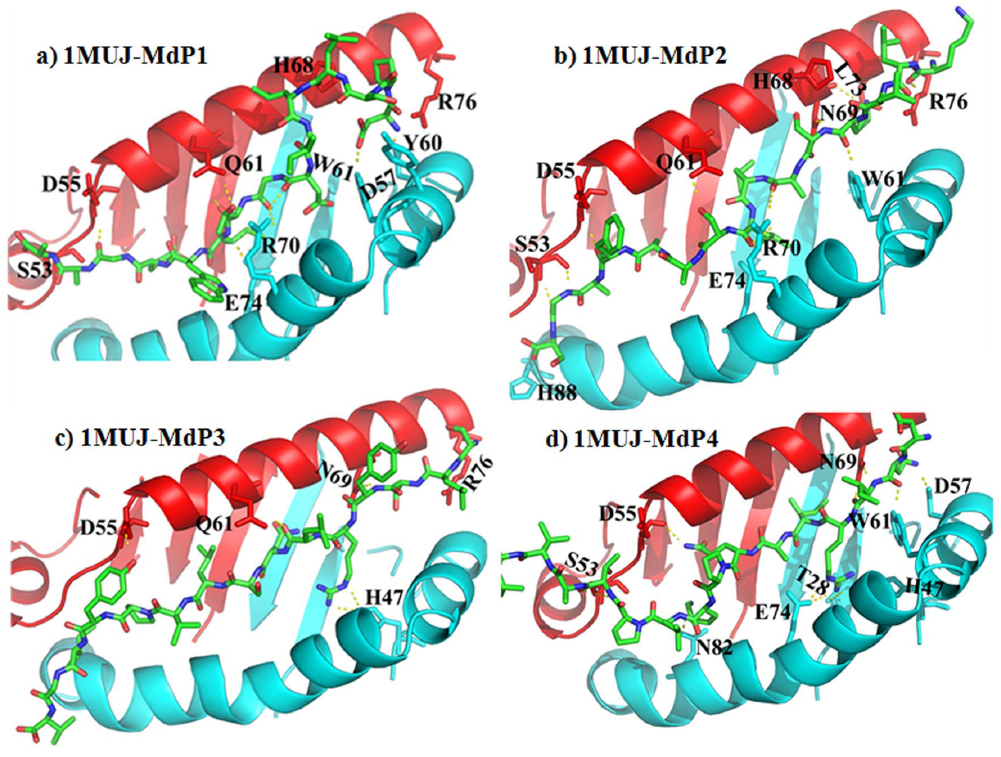
Figure 6. MOMP-derived peptide docking to I-Ab MCH II. Cartoon representations of the docked poses of four novel MOMP-derived peptides (MdP1-4, a–d) and the mouse I-Ab MCH II (PDB code 1MUJ). The peptides are coloured by element (green carbon; blue nitrogen; red oxygen). a - chains of the MHC II are coloured red, b -chains of the MHC II are coloured cyan. Yellow dashes represent potential hydrogen bonding.